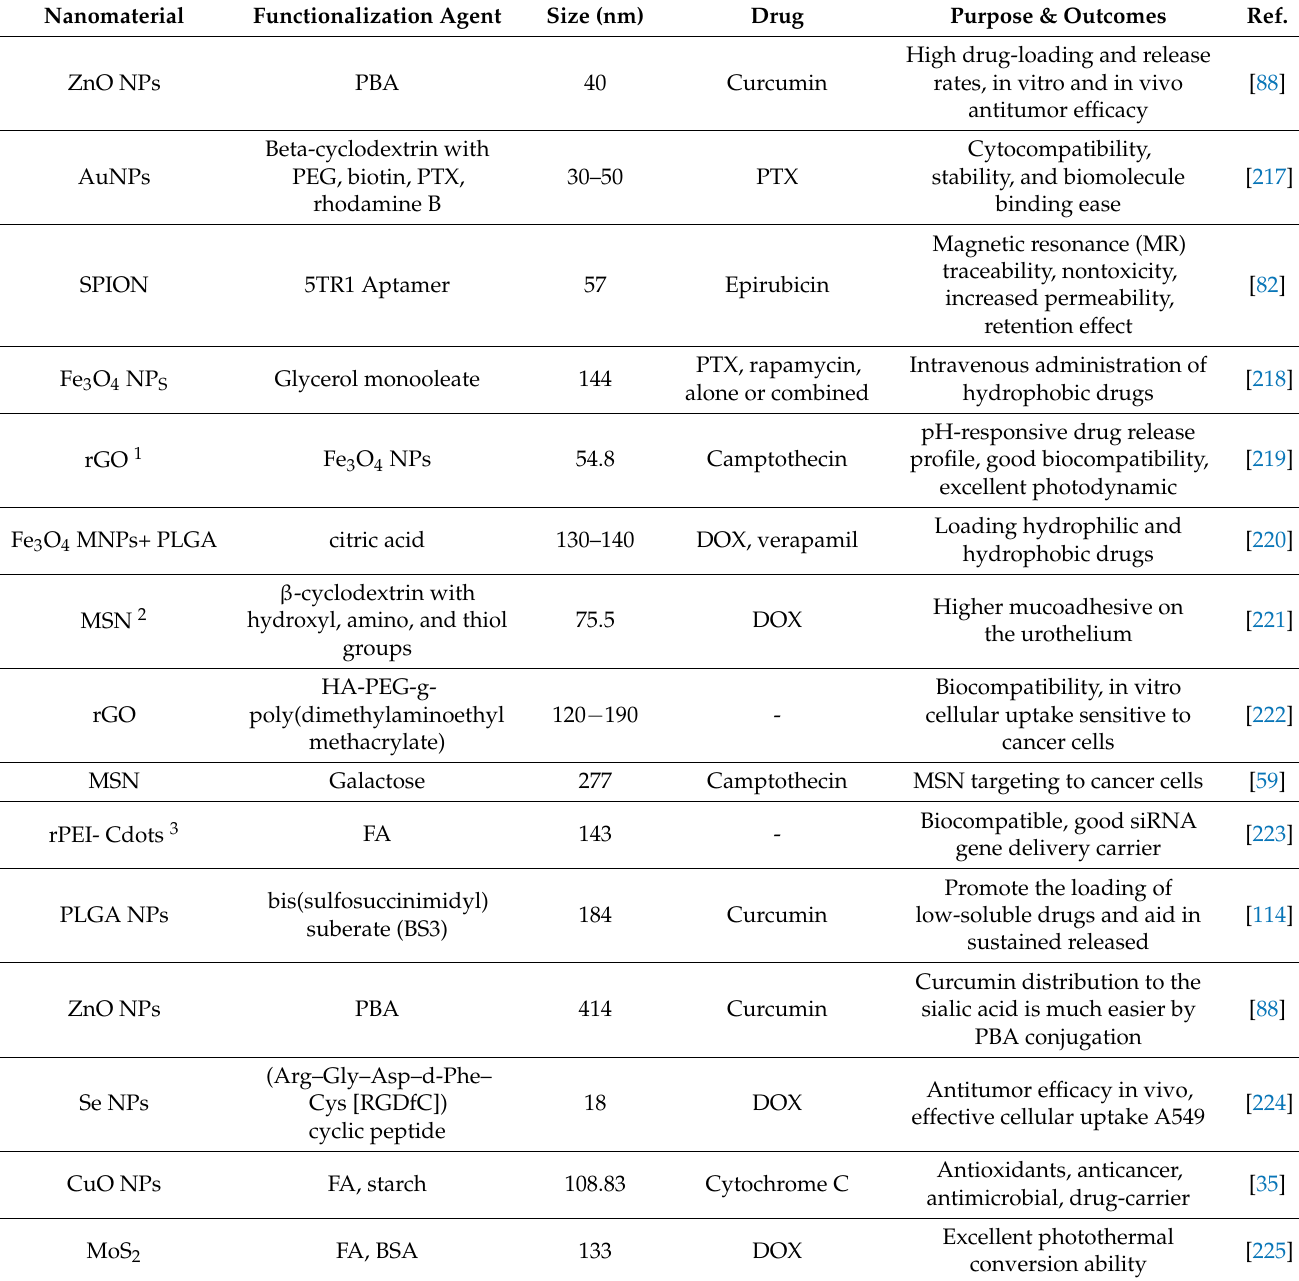
Table 4. Functionalized nanomaterials used for cancer